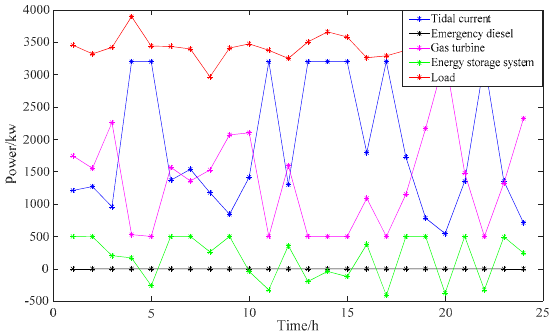
Figure 10. Power output curve of units in island operation mode.